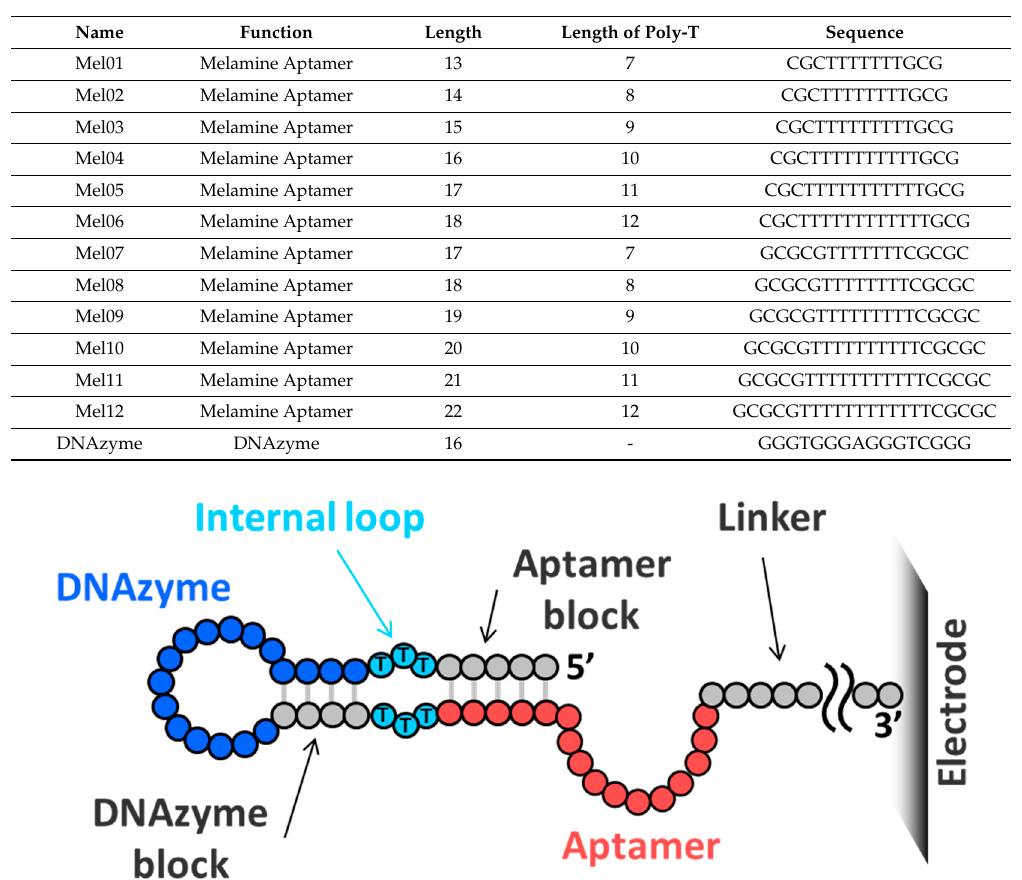
Table 1. Melamine aptamers modified from the original poly-T melamine aptamer and a designed peroxidase-mimicking DNAzyme used for screening.